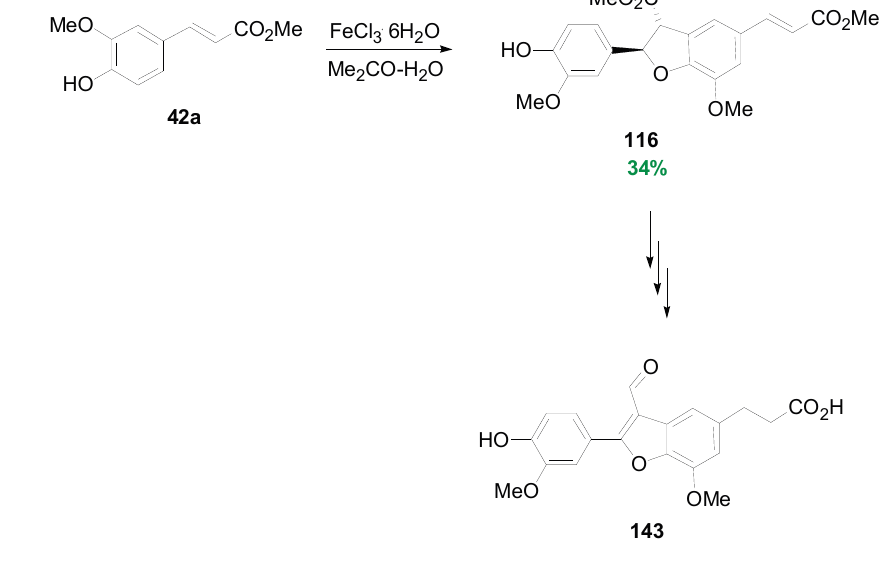
Scheme 56. Ag 2 O-mediated POC of Me-Fer and application to the synthesis of the dihydrobenzofuran-gallic acid hybrid 147